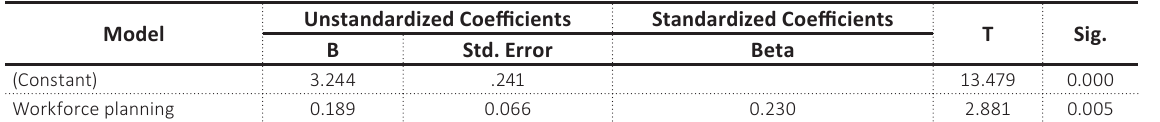
Table 6. Regression coefficients for